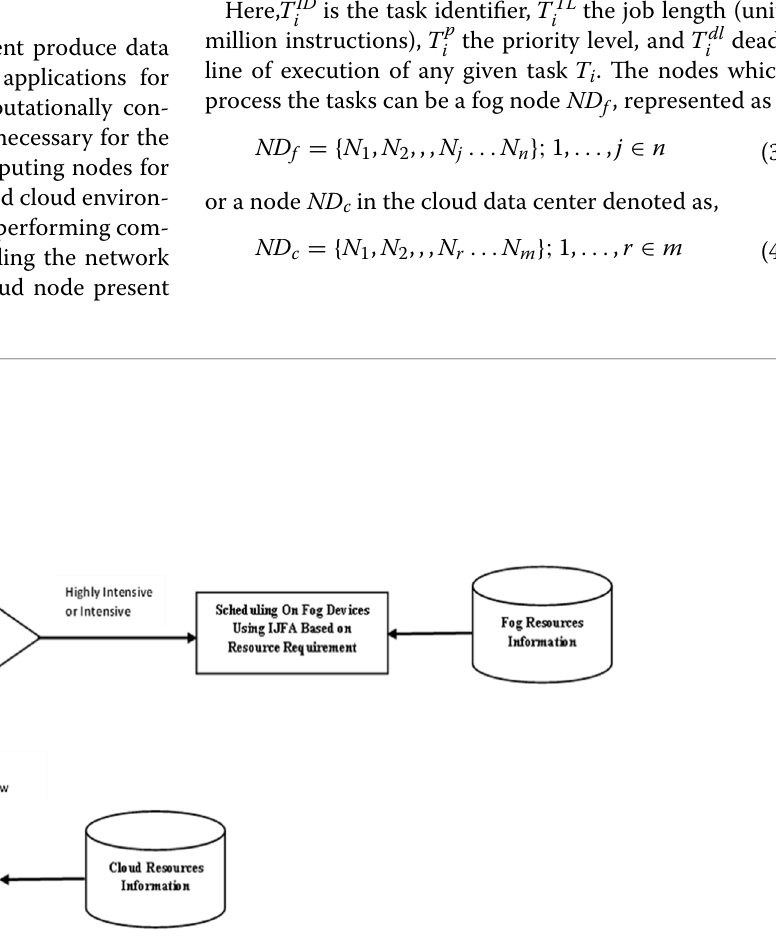
Fig. 3 Workflow of the proposed